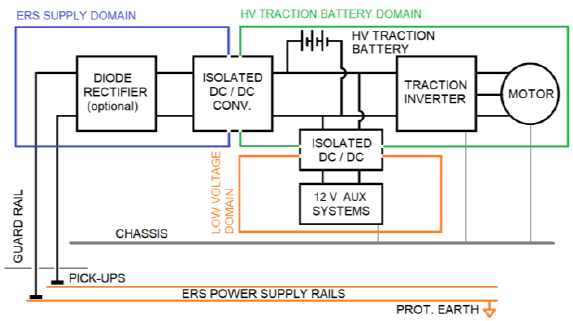
Figure 1. General system’s schematic .